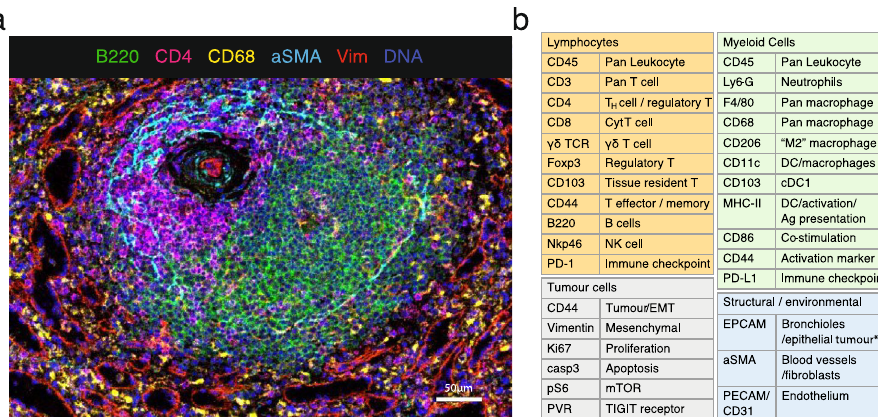
Fig. 1 A 27 multiplex antibody panel to characterise the TME in mouse frozen tissues. a Validation of antibodies in IMC using a tissue with known staining patterns, an example shown here is a follicle in the spleen; Ir191/193 (blue), B220 (green); CD4 (magenta), CD68 (yellow), α SMA (cyan), vimentin (red). Representative image of two independently stained spleen tissues. b Panel of 27 antibodies that identify multiple cell types from lymphoid, myeloid, tumour and stromal compartments, as well as markers of activation and proliferation status. Detailed information on the antibody clones and isotope conjugations can be found in Supplementary Tables 1 and 2. DC dendritic cells, NK natural killer, EMT epithelial-to-mesenchymal transition, Ag